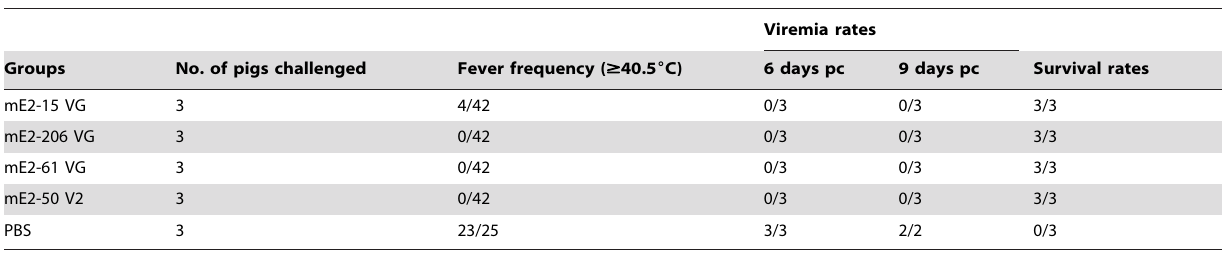
Table 2. Clinical outcomes of pigs following viral challenge.